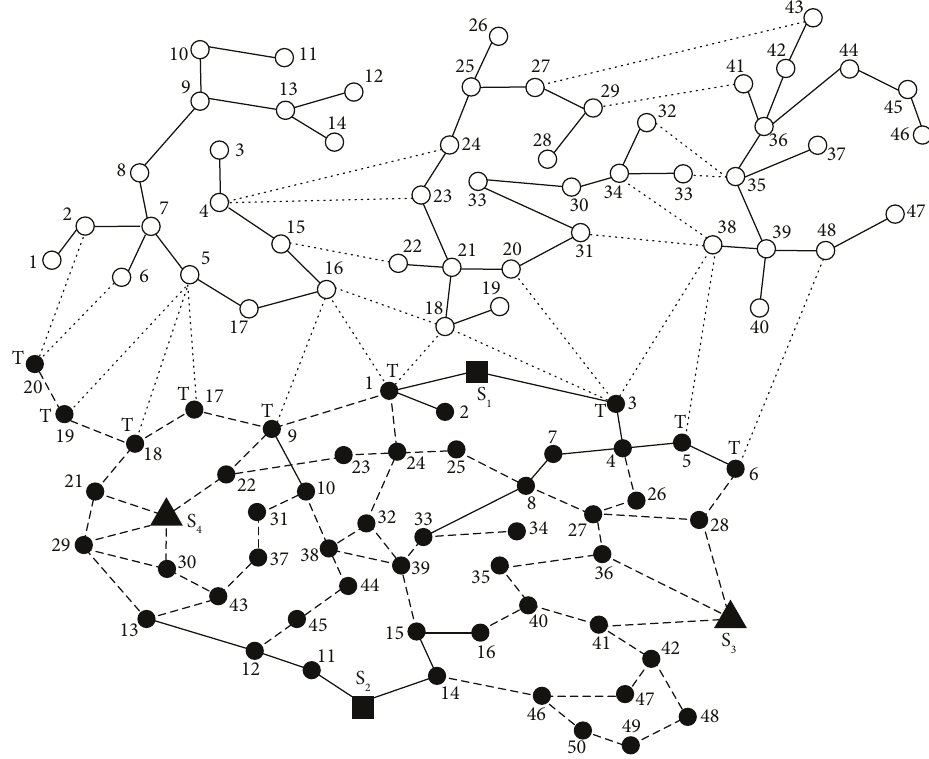
Figure 6: The studied distribution